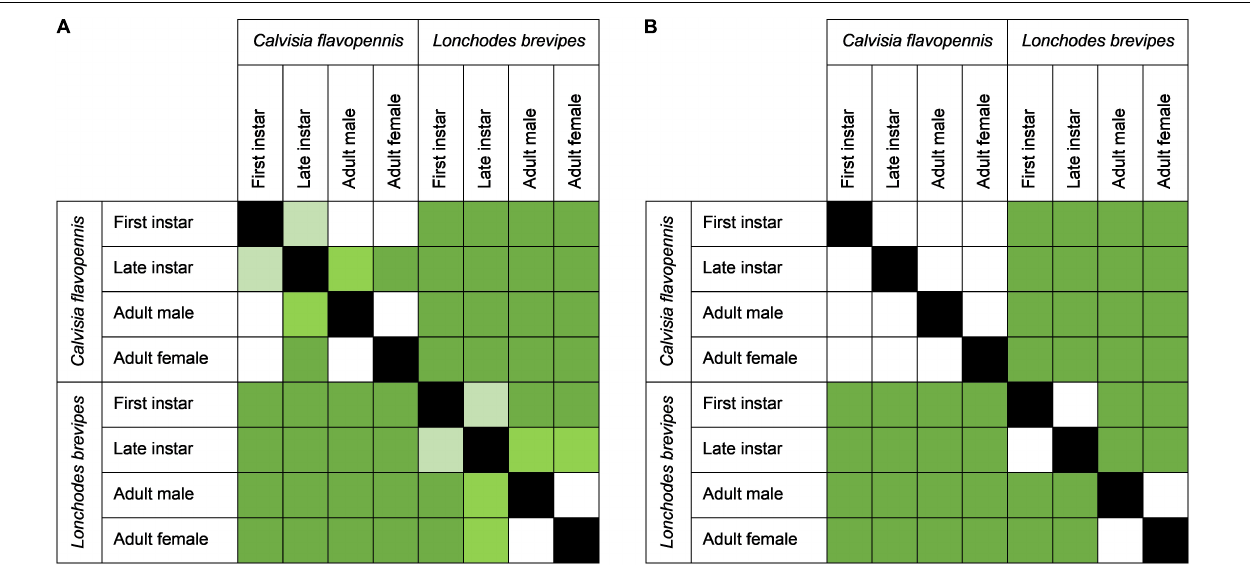
FIGURE 3 | Heat maps of the pairwise comparisons of overall behavioral responses across species and life stages in (A) the control treatment and (B) the wind treatment. The intensity of green in the squares indicates the significance levels of Benjamini–Hochberg adjusted p -values of comparisons between morphological types, dark green, p < 0.001; medium green, p < 0.01; light green, p < 0.05, while white squares represent comparisons that were not statistically significant. Black boxes indicate no comparison (same morphological type).